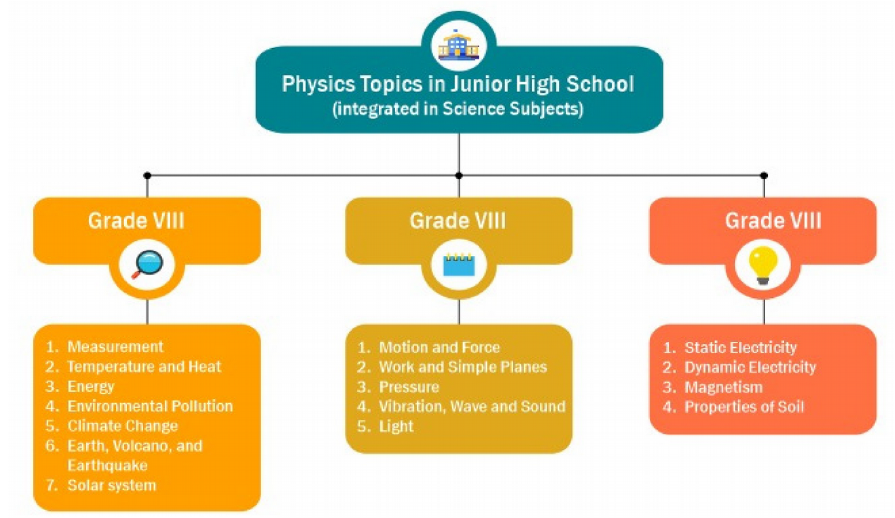
Figure 1. Physics topics in junior high school